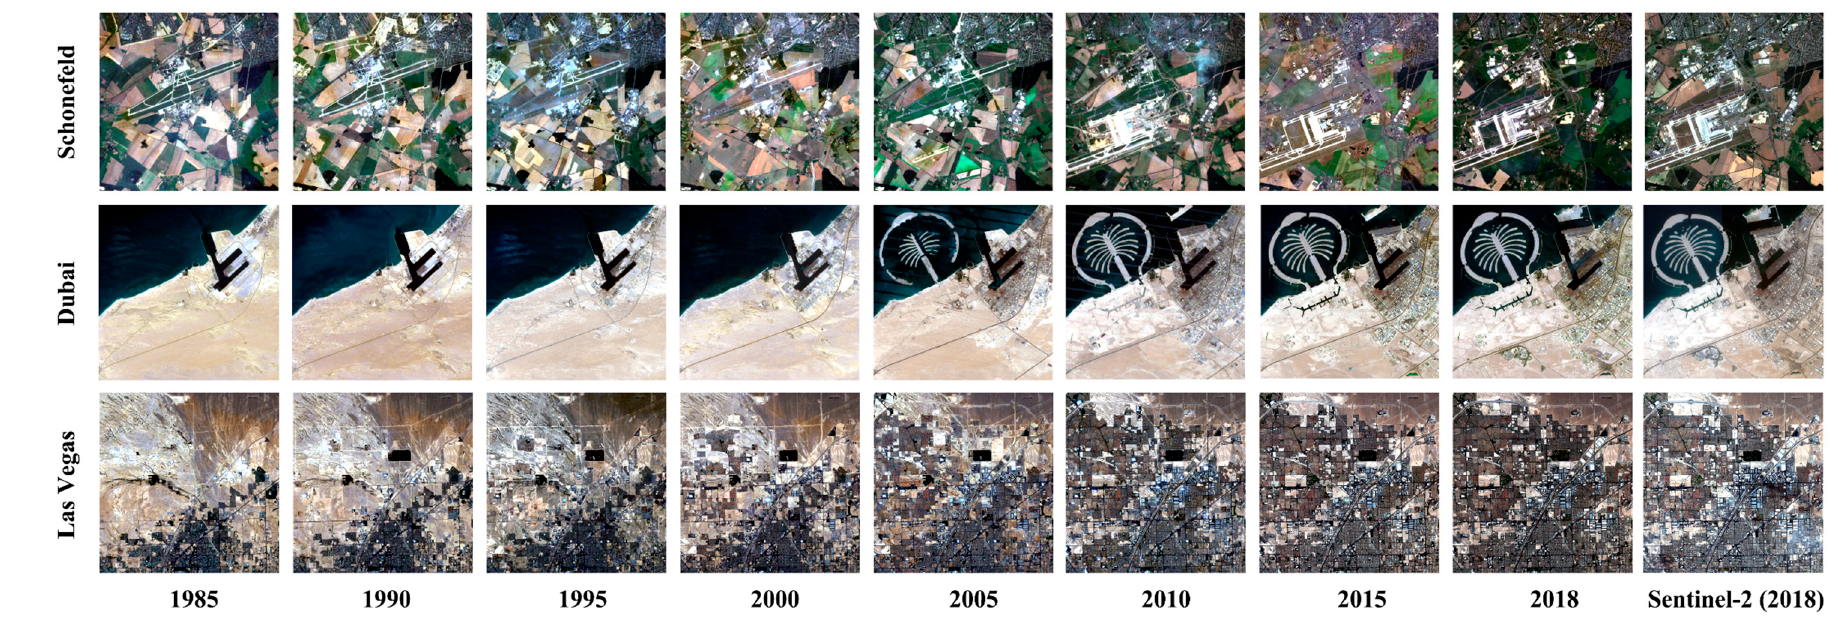
Figure 11. Historical reconstruction of 10 m Sentinel-2-like images in Schonefeld, Dubai, and Las Vegas from 1985 to 2018, and the corresponding Sentinel-2 observations in 2018.